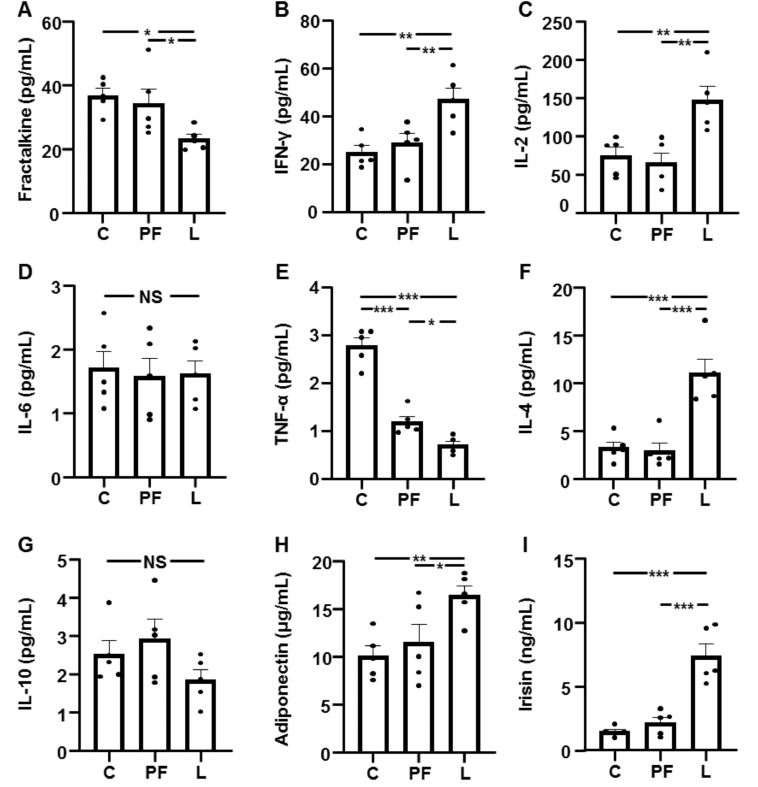
Figure 1. Circulating concentrations of cytokines. Serum fractalkine ( A ), interferon (IFN) γ ( B ),